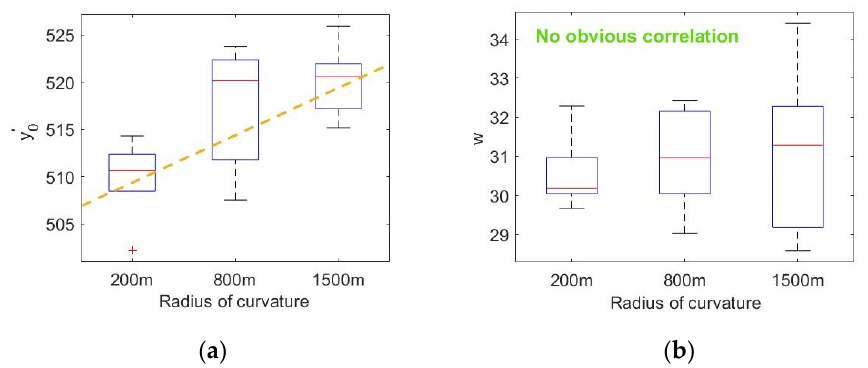
Figure 13. Relationship between fitting parameters and radius of curvature: ( a ) relationship between radius of curvature and (cid:1877) (cid:2868)(cid:4593) and ( b ) relationship between radius of curvature and (cid:1875) .